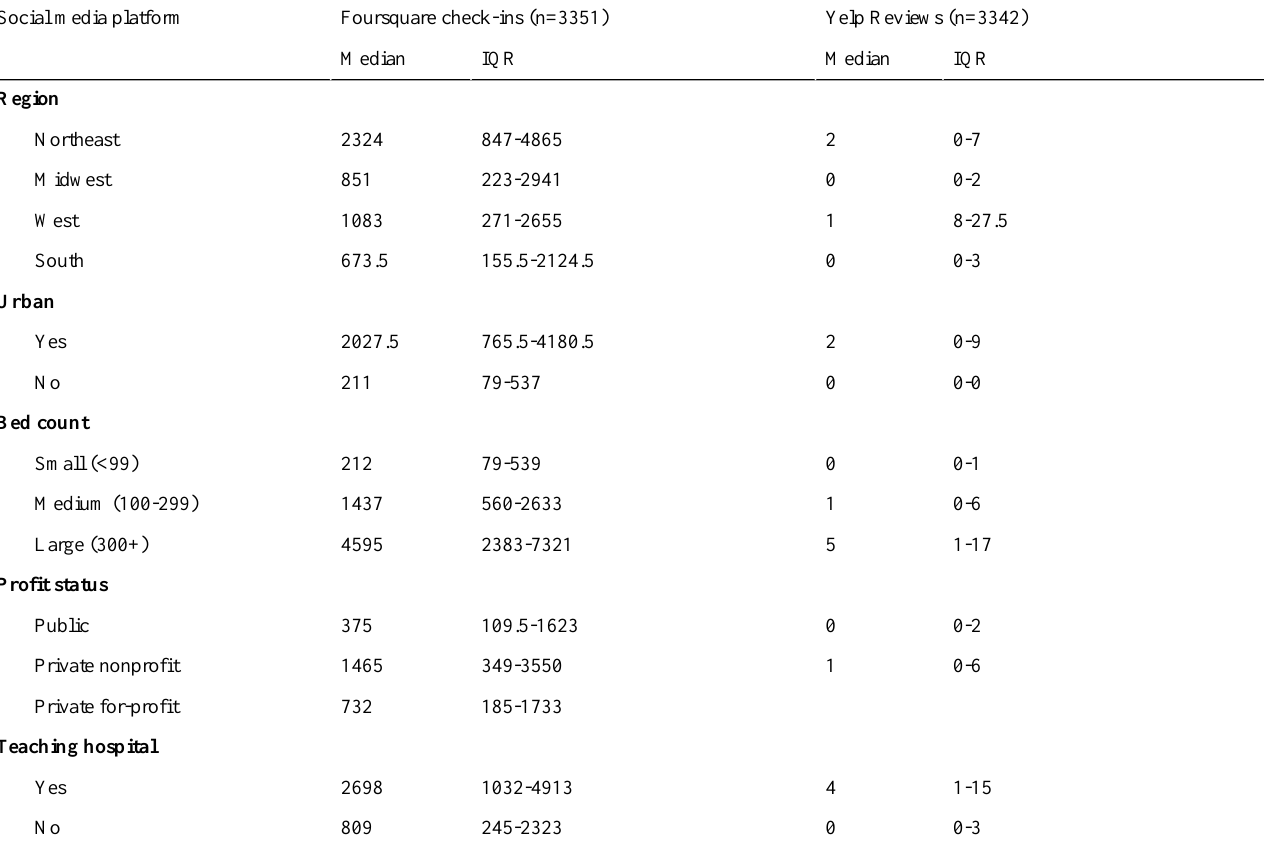
Table 2. Magnitude of social media utilization relative to hospital characteristics: Foursquare and Yelp.